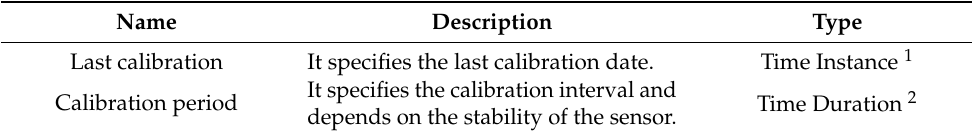
Table 4. Calibration TEDS structure for a generic